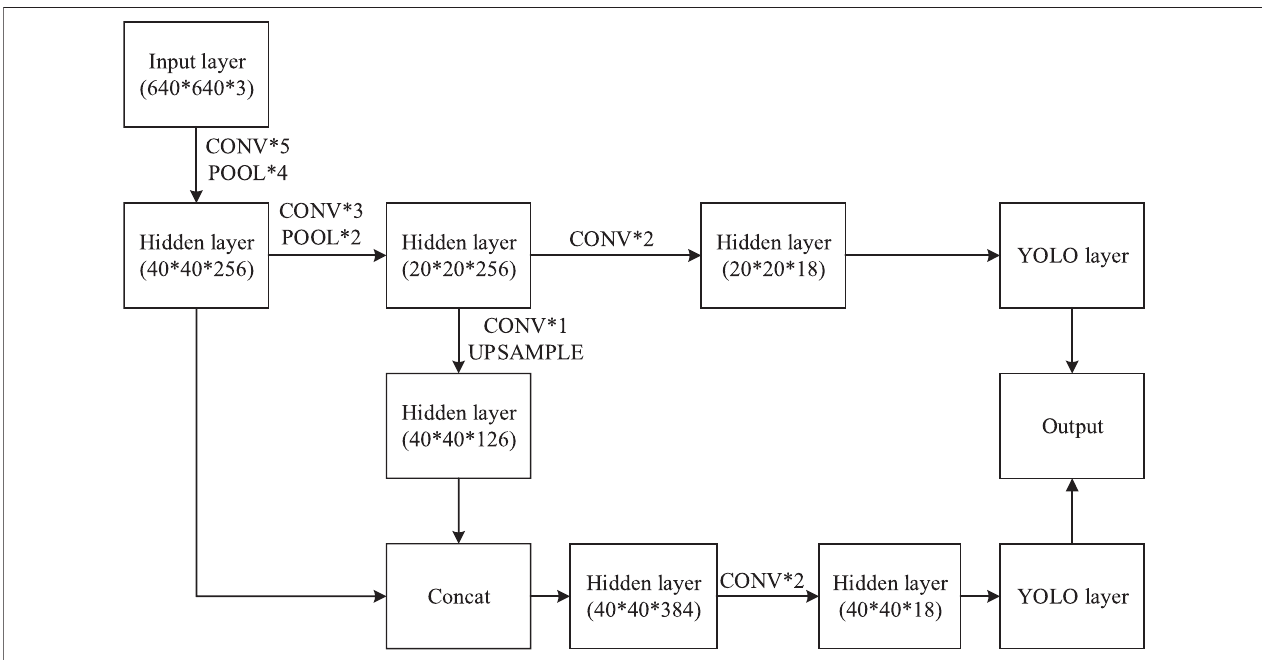
FIGURE 1 | YOLOv3 Tiny Network structure diagram. CONV is a convolution operation, POOL is a pooling operation, and UPSAMPLE is an up sample operation.